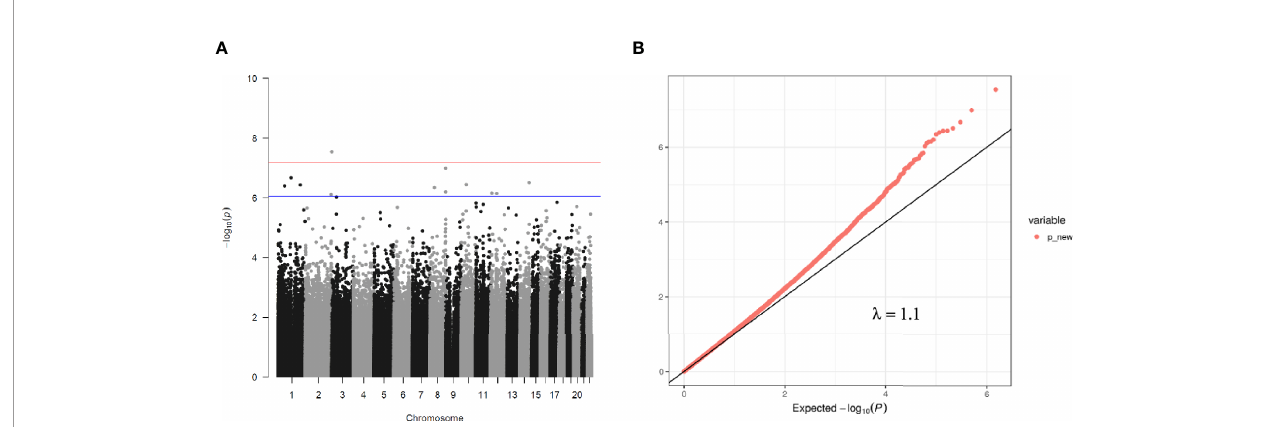
FIGURE 1 | (A) Manhattan plot of EWAS between PG at 1 h after birth and DNA methylation levels of 754,255 CpG sites. (B) QQ plot of EWAS p-values.